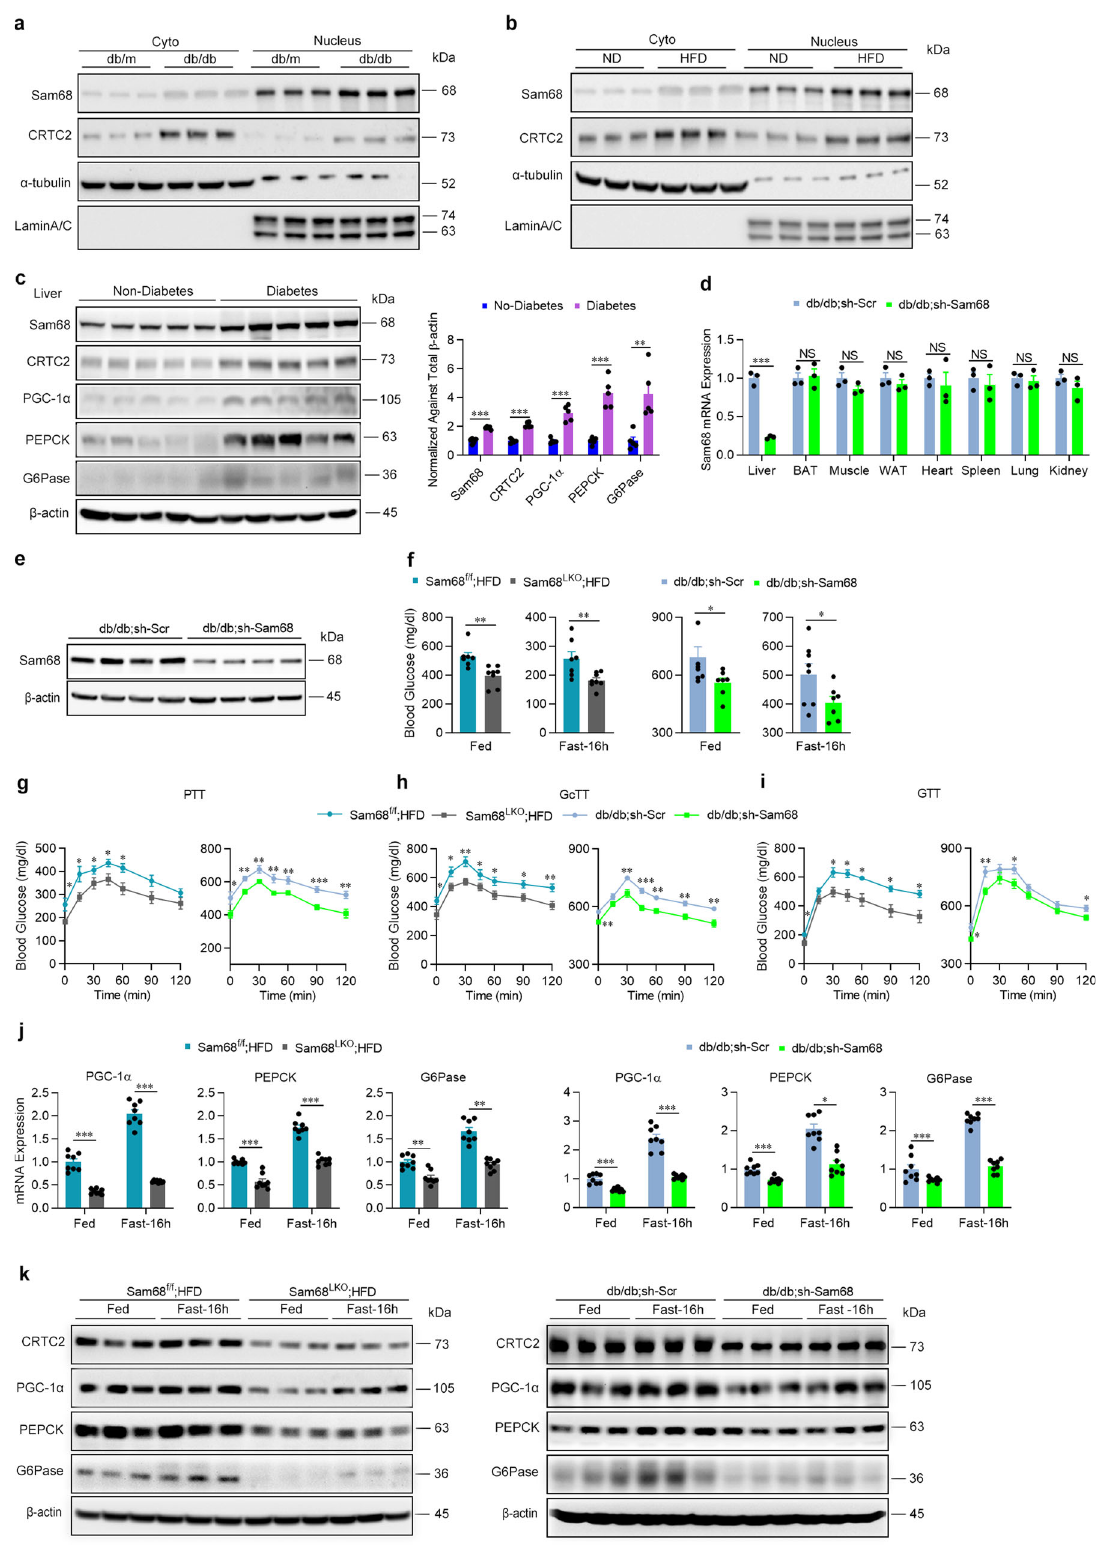
Sam68 in rat adipocytes 49,50 , and a variety of posttranscriptional modi fi cations, including tyrosine phosphorylation 18 , serine/ threonine phosphorylation 51 , acetylation 52 , methylation 53 , and SUMOylation 54 , are associated with Sam68 localization and sta- bility. Thus, it is likely that under diabetic conditions, deregulated metabolic signaling (e.g., glucagon and insulin) result in